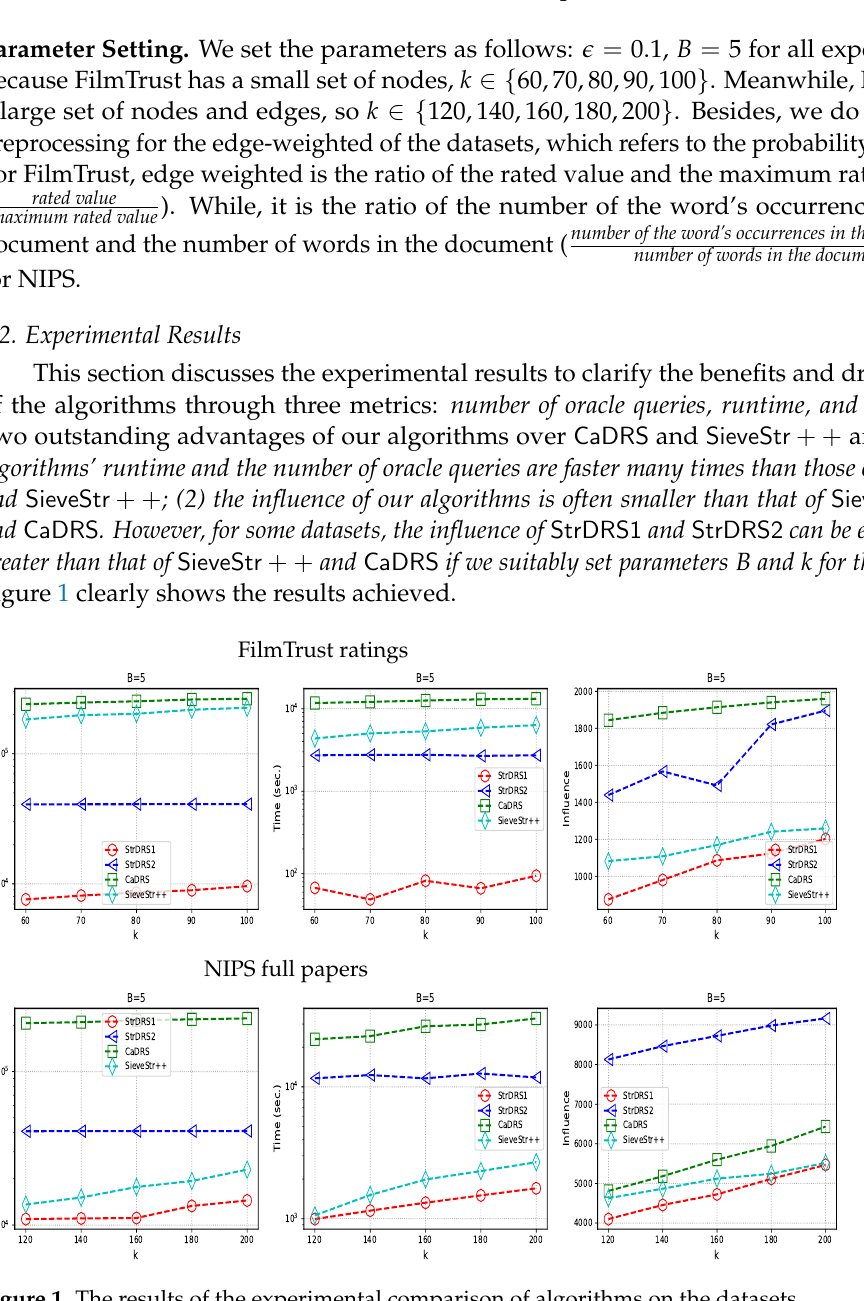
Figure 1. The results of the experimental comparison of algorithms on the